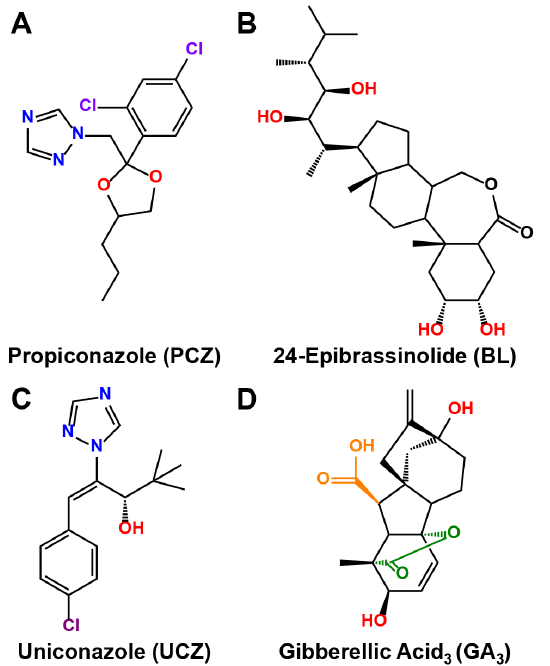
Figure 1. Chemical structures of propiconazole (Pcz), uniconazole (Ucz). 24-epibrassinolide (eBL), and gibberellic acid 3 (GA 3 ). Structure elements critical for inhibitor activity in Pcz and Ucz have been color- coded: (blue) nitrogen atoms in the azole ring; (purple) chlorine atom(s) of the phenyl ring; and (red) either primary/secondary hydroxyl group or 1,3-dioxlane. In GA 3 , the 4,10-lactone bridge is depicted in green and the carboxyl group is depicted in orange. Hydroxyl groups in 24-epibrassinolide and GA 3 are depicted in red. Structures were drawn using the ChemBioDraw 12.0.2 software and structures were compared to the ChemACX 12.12.1 database.